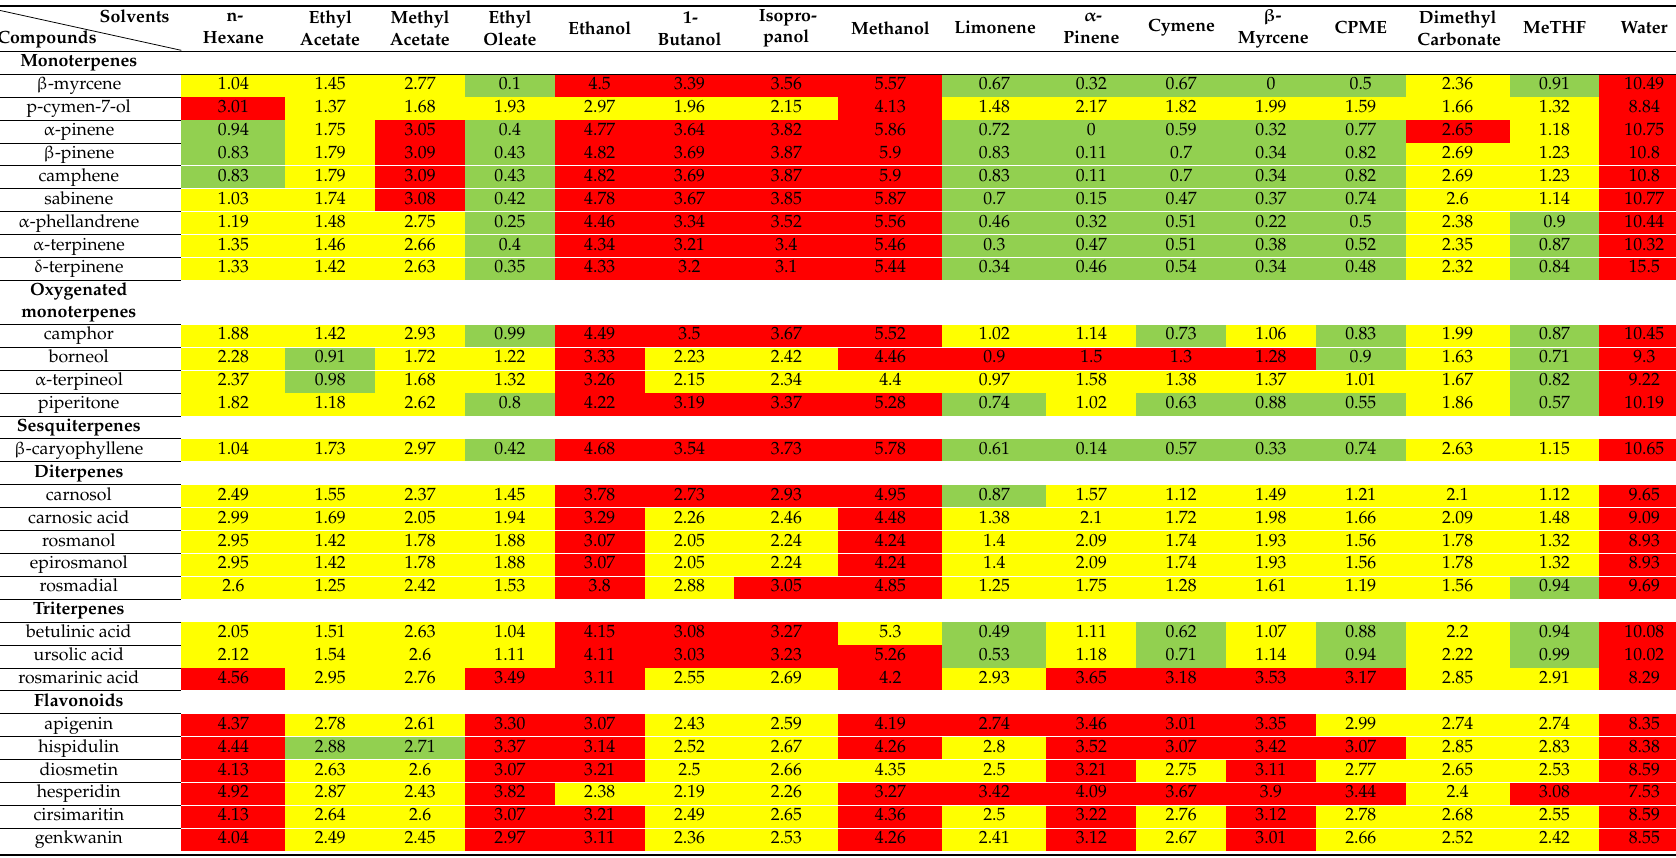
β - α - Cymene Myrcene CPME Pinene